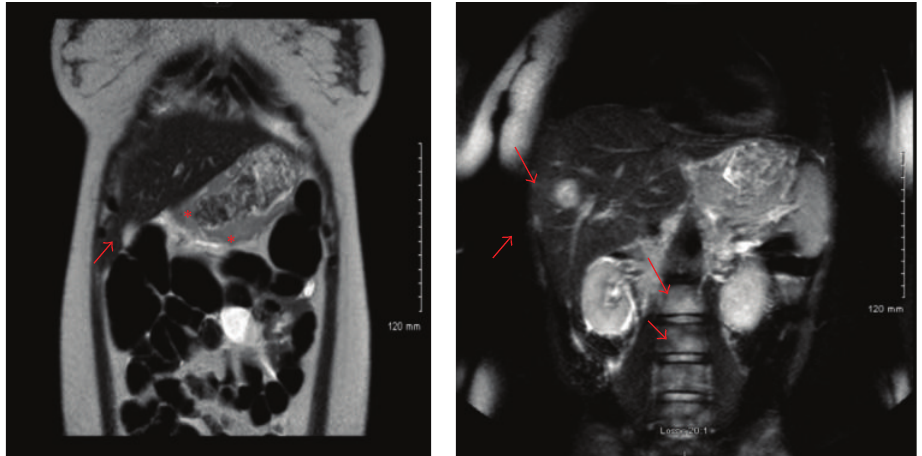
Figure 2: MRI with and without contrast of the abdomen showing at least two liver metastases, stomach thickening, and spinal metastasis.